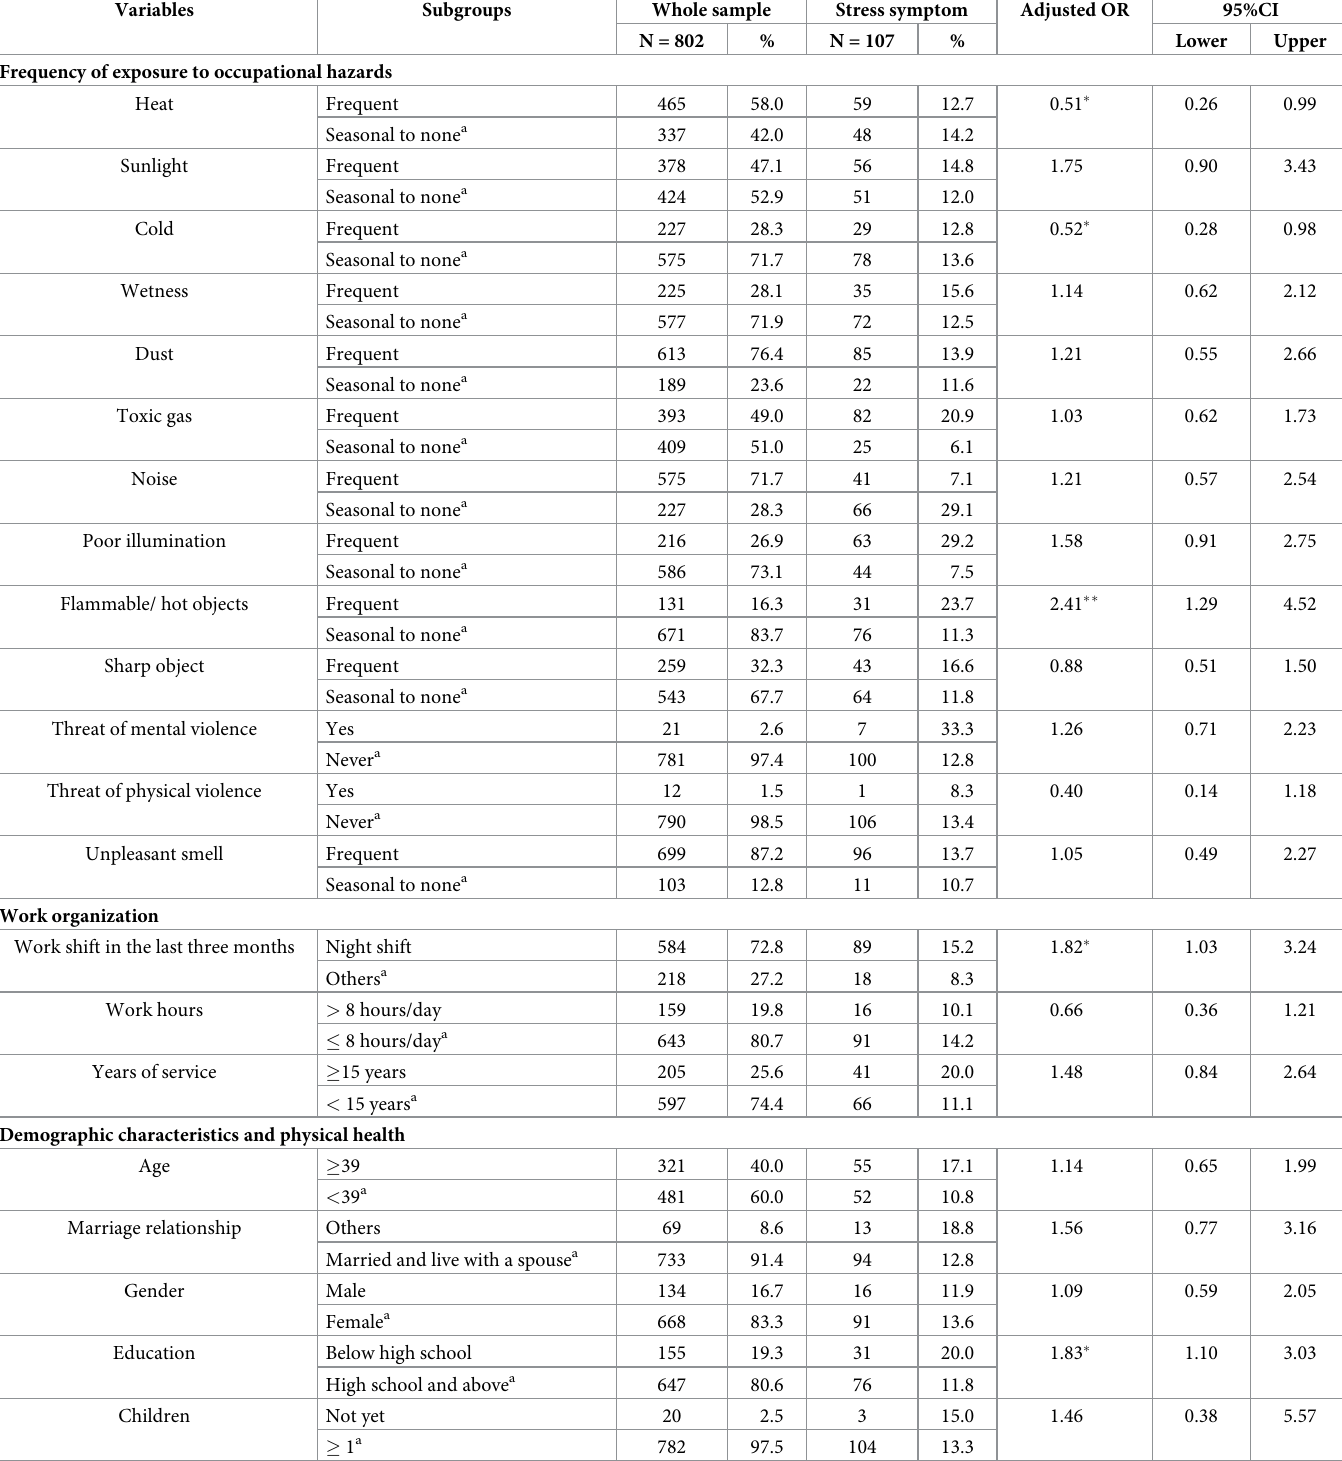
Table 2. Factors associated with psychological stress among waste collectors in this study. Multivariate Logistics regression (N = 802). Variables Subgroups Frequency of exposure to occupational hazards